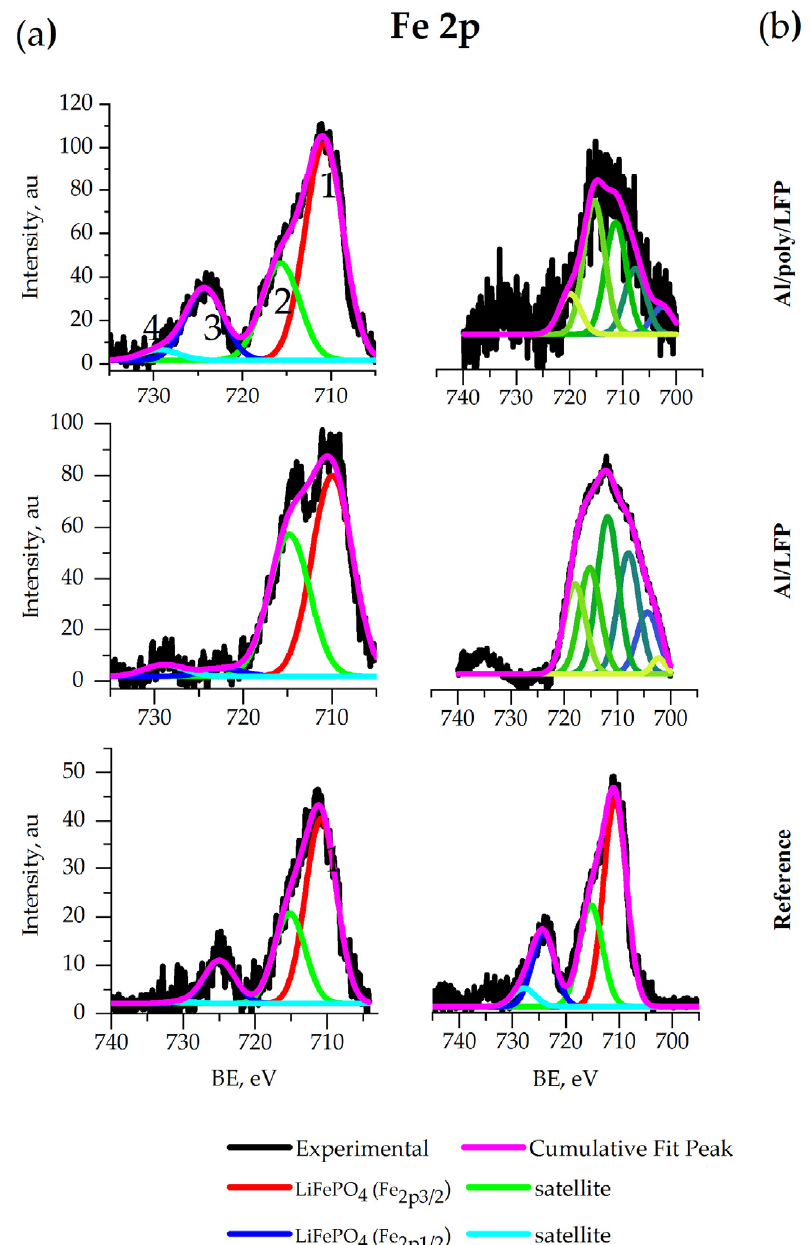
Figure 13. XPS spectra of Fe 2p for coin ( a ) and pouch ( b ) cells. Pouch cells electrodes XPS. Figure 10 b shows that the C 1s spectra of all samples contain bands characteristic of the C–C sp 2 -bond, which indicates carbon black presence in the sample [64]. Additionally, these spectra contain peaks of C–H and C–F bonds in the CF 2 –CF 2 group [64], corresponding to the presence of PVDF. The carbon black and binder peaks persist after short circuit test; however, the ratio of their intensities changes. In contrast to the spectrum of the reference set, a peak of ethers is detected in all overcharged sets (C–O, about 286.9 eV). The ethers are the products of the electrolyte (1 M LiPF 6 EC:DEC) decomposition reaction. The intensity of the peak was lower for all protected samples. The signal at 284.6 eV corresponds to sp3-hybridized aliphatic carbon